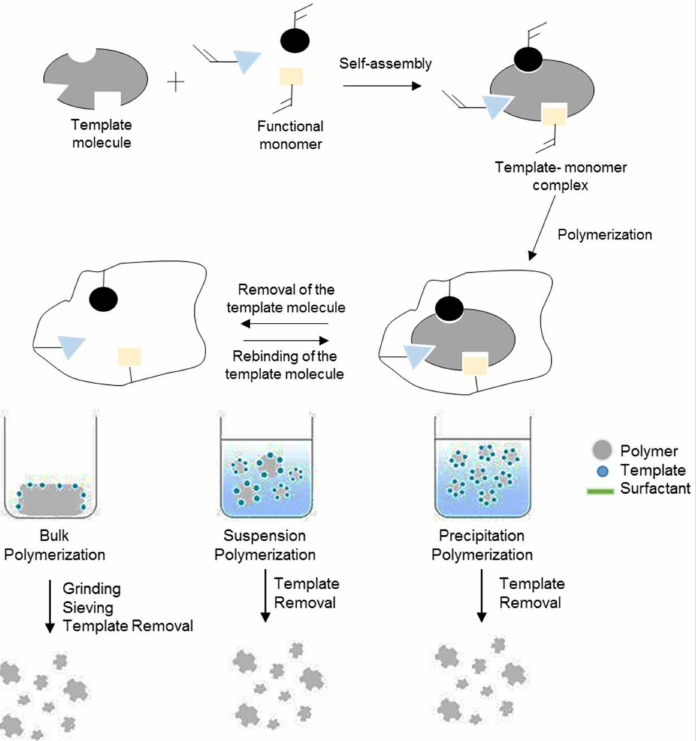
Figure 4. General scheme of polymerization techniques used for the preparation of MIP